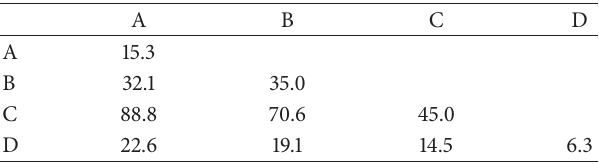
Table 6: Average distance between WINNER scenario groups: A, B, C, and D.